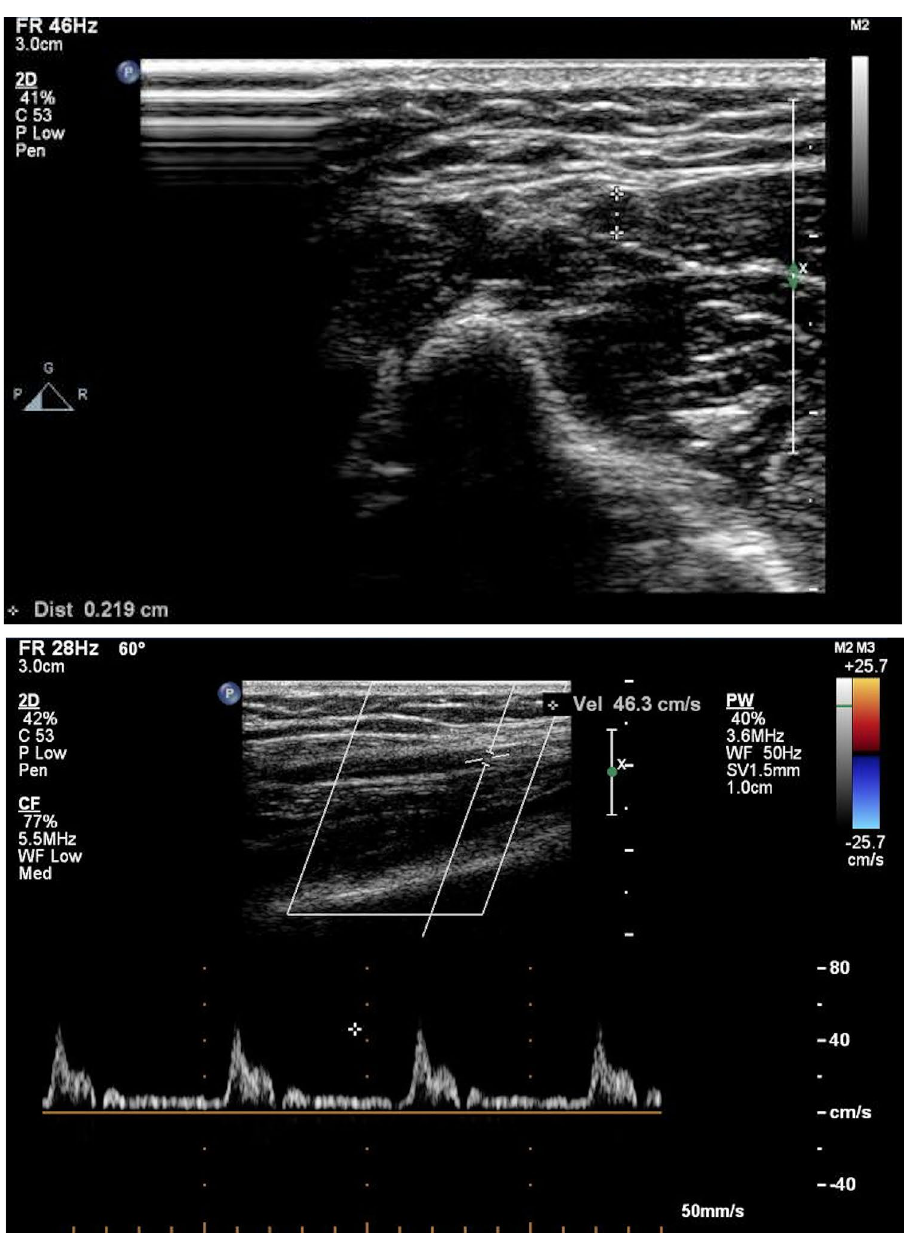
Figure 1. Ergonovine provocation test of radial artery measured by ultrasound. ( A ) Short axis view indicating the inner diameter of the radial artery. ( B ) Spectral Doppler indicating the peak systolic velocity of the radial